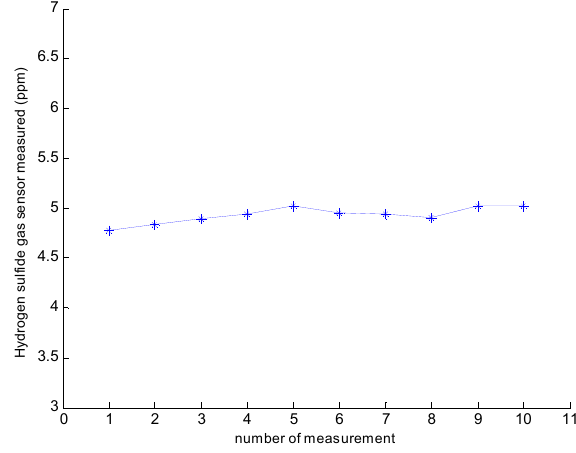
Figure 4. Repeatability of the Measurements.